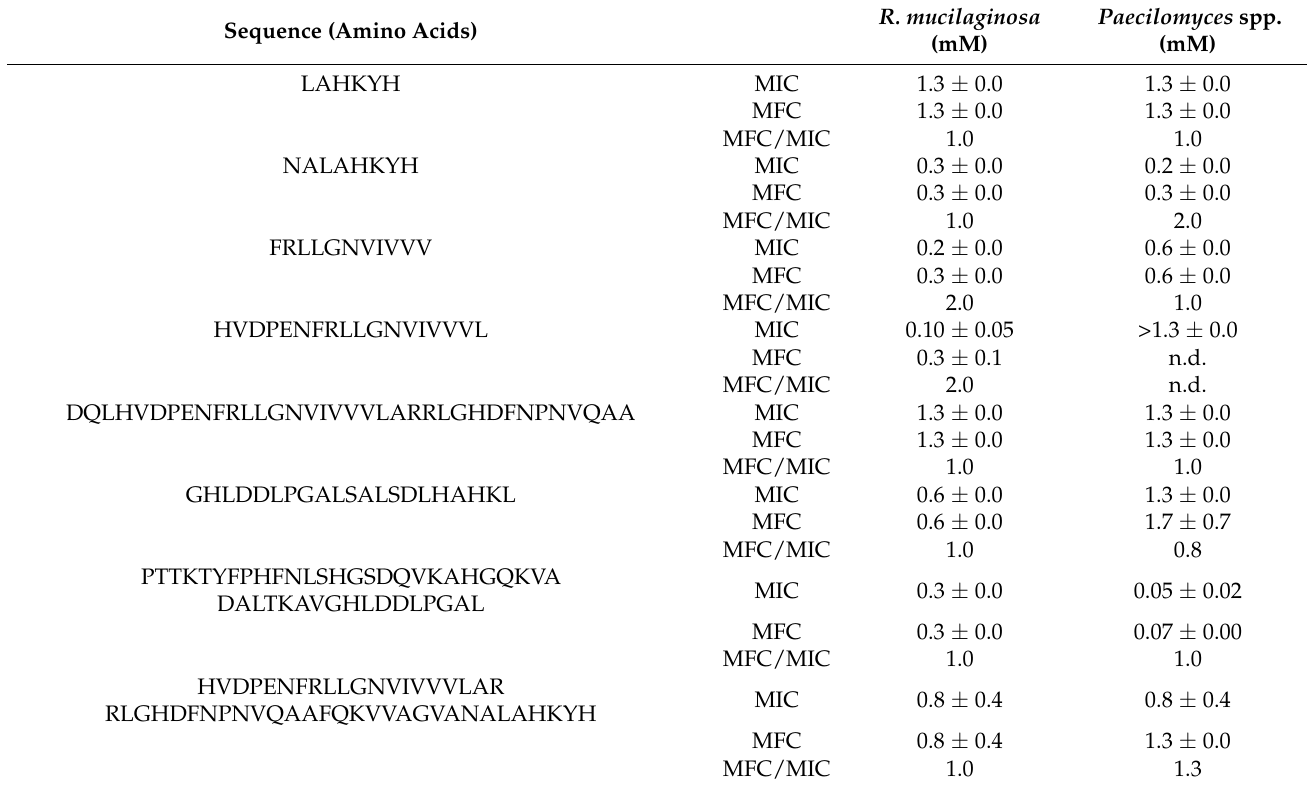
Table 7. Minimal Inhibitory Concentration (MIC) and Minimal Fungicidal Concentration (MFC) of the synthesized peptides for a yeast and a mold indicator